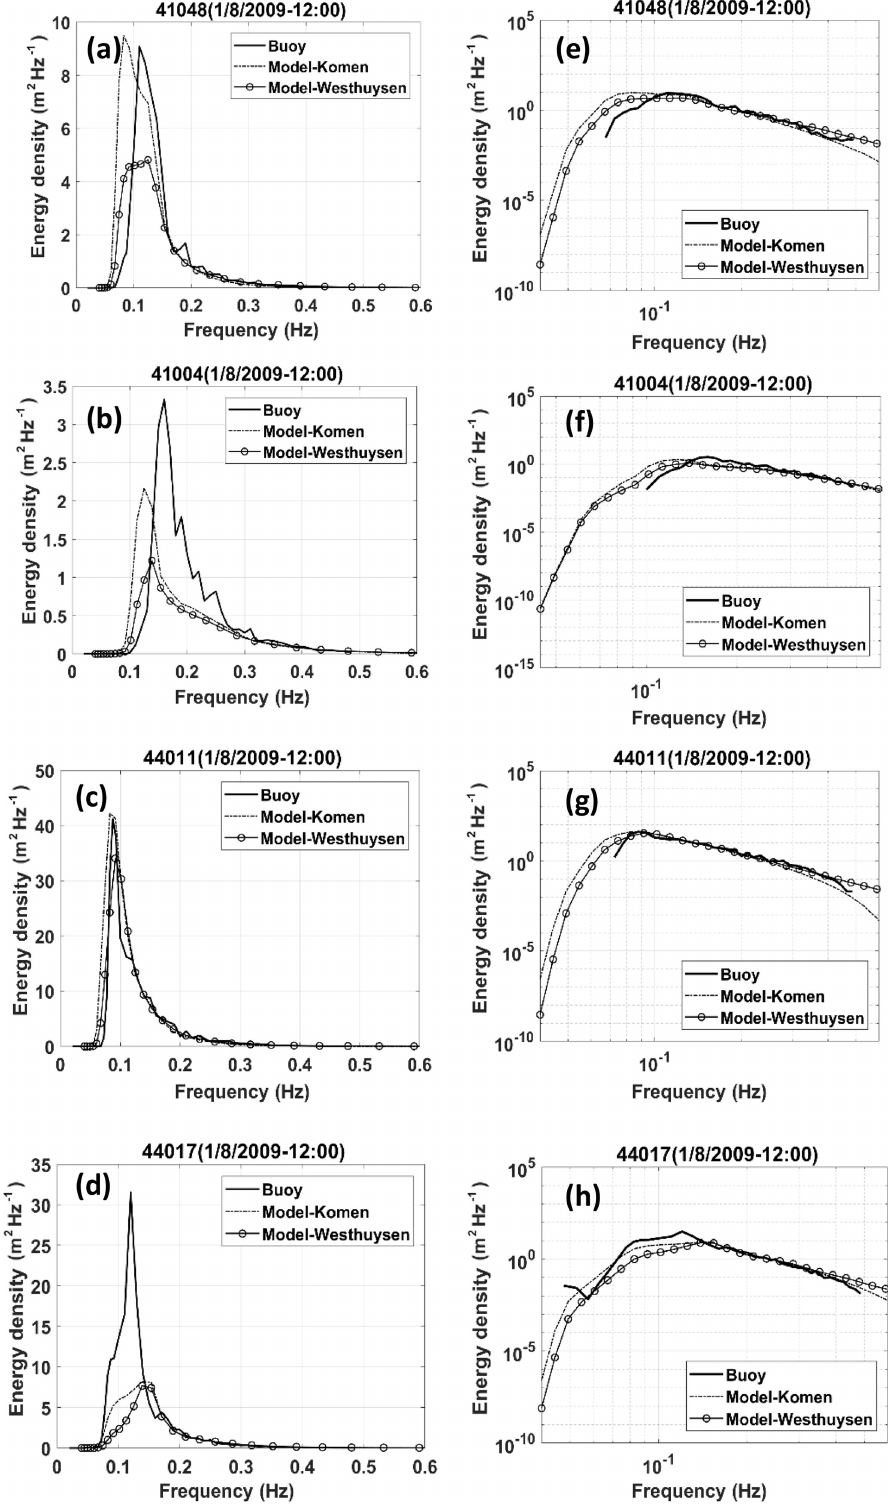
Figure 10. Comparison between the observed (solid lines) and simulated (dashed for Komen, circles for Westhuysen) frequency spectra at t1 at the four NDBC stations: panels ( a , c , e , g ) show the linear scale for the energy axis and panels ( b , d , f , h ) show the logarithmic scale for the energy